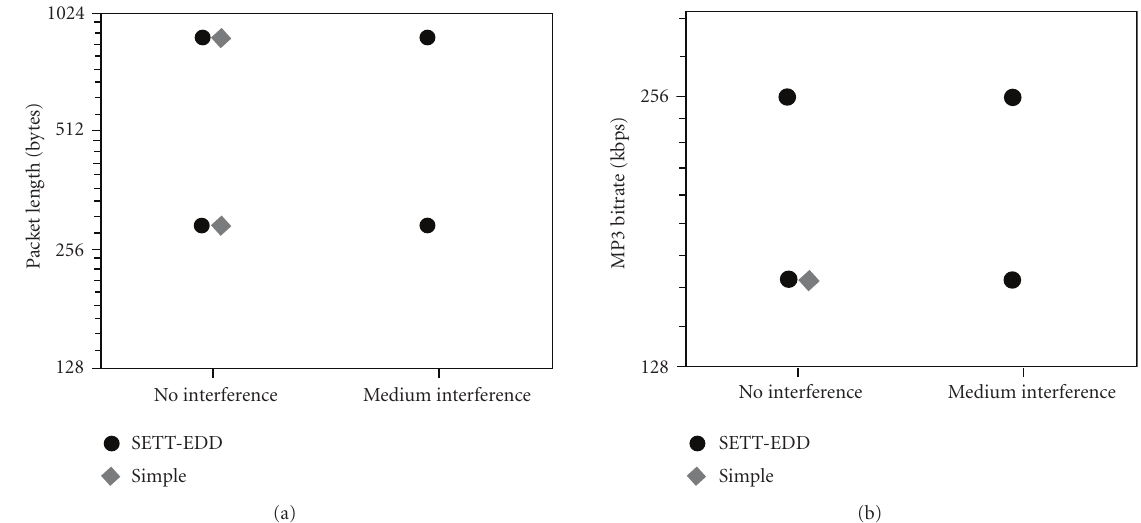
Figure 13: Parameter map for error-free stereo digital audio WLAN delivery: (a) PCM f s = 44 . 1 KHz, N = 16bit; (b) mp3 coded at 160 Kbps and 256Kbps.